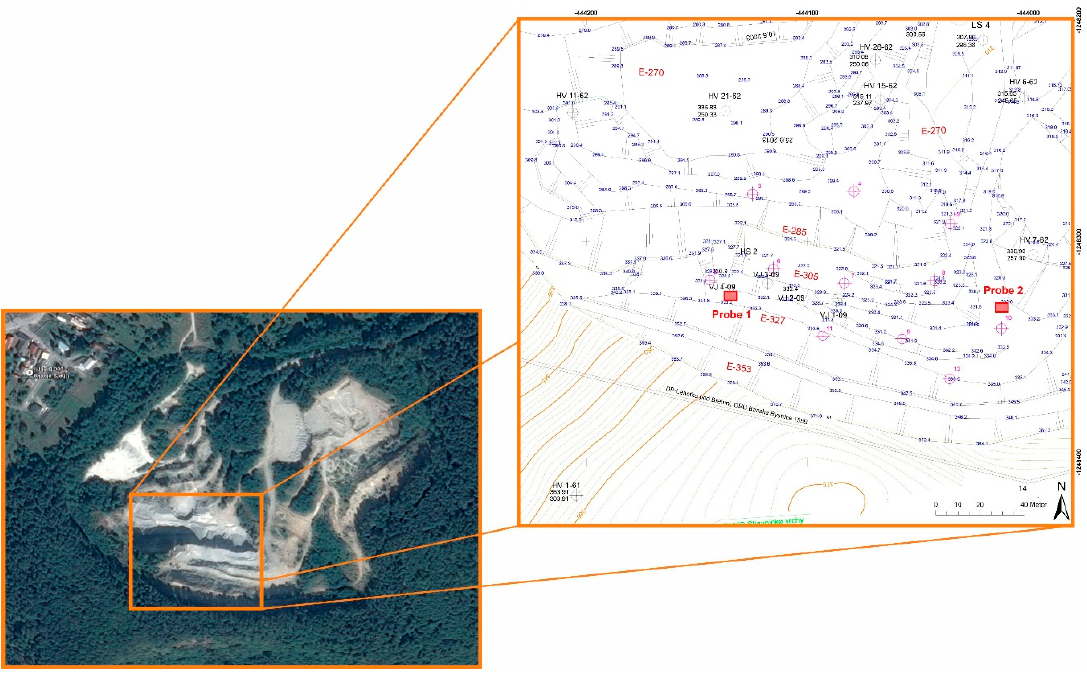
Figure 5. Localization of large-scale samples Probe 1 and Probe 2 in the perlite quarry Lehôtka pod Brehmi.